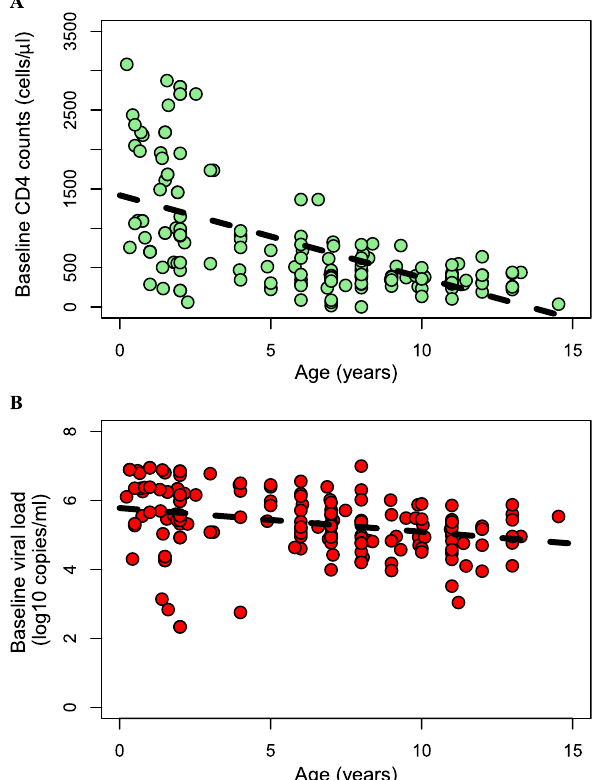
Figure 1. Dependence of baseline characteristics on age. ( A ) Baseline CD4 T cell count decreases significantly with age (Pearson ρ = − 0.63; P = 2.2 × 10 –16 ). ( B ) Baseline viral load also decreases with age (Pearson ρ = − 0.313; P = 3 × 10 –5 ). Each dot represents an HIV-1 infected child (n = 171) and the dashed lines are linear regression lines.